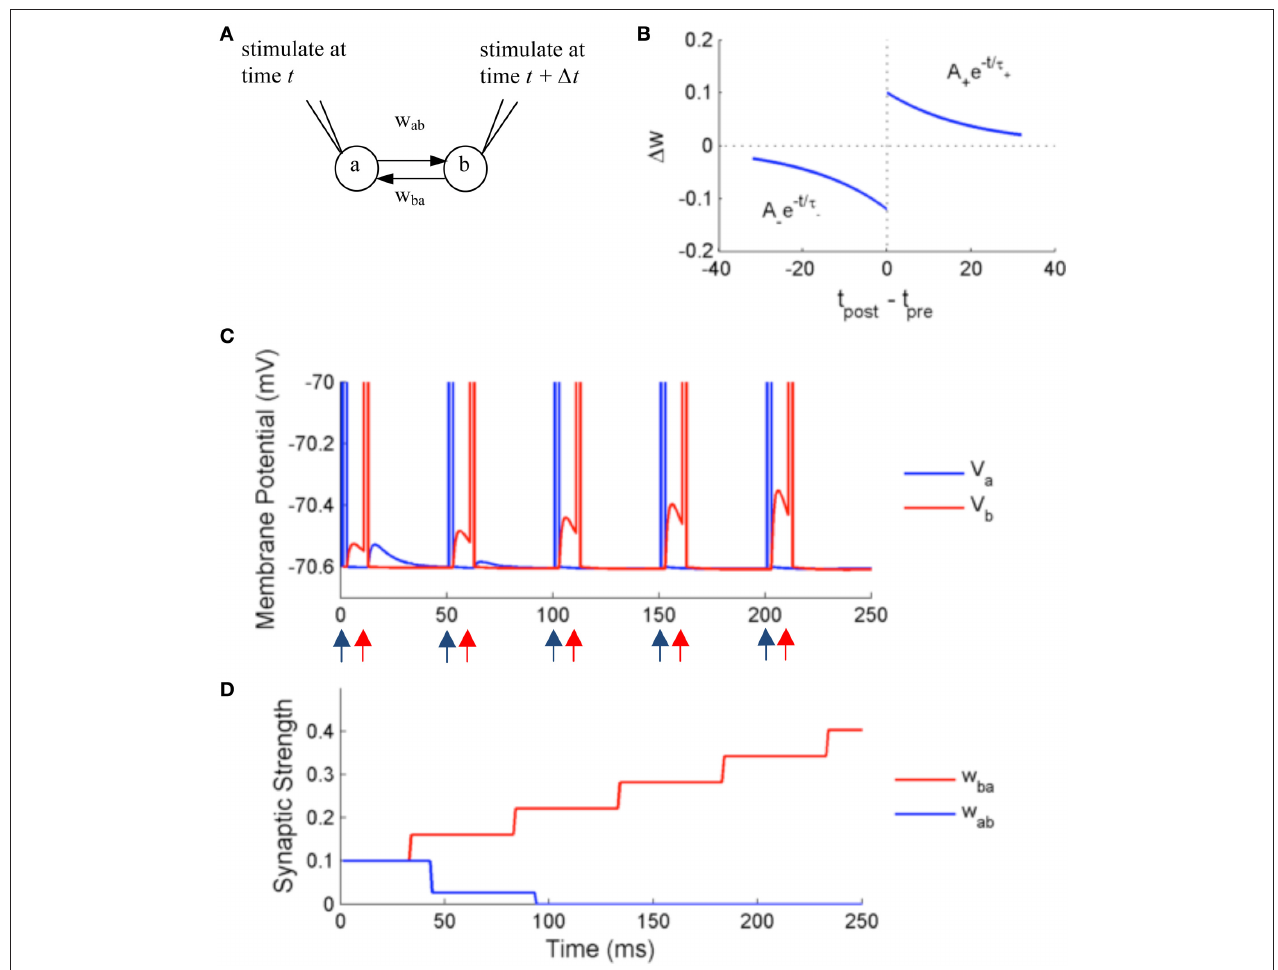
FIGURE 7 | Simulation using NeuroFlow with STDP enabled under the paired stimulation protocol. (A) The simulation consists of two aEIF neurons which are mutually connected. Each of them receives an alternate stimulation of 10mA for 250ms. (B) The STDP profile used for the simulation, with A + = 0.1, A − = 0.12 and τ + = τ − = 20ms (C) Traces of membrane voltage of the two neurons with spike time difference of 10ms. The neurons spike upon receiving the external stimulation, where blue (red) arrows correspond to the time when neuron a (neuron b) receives external stimulation in the diagram. (D) Evolution of the strength of synaptic coupling between the two neurons across time in the trial described in (C)